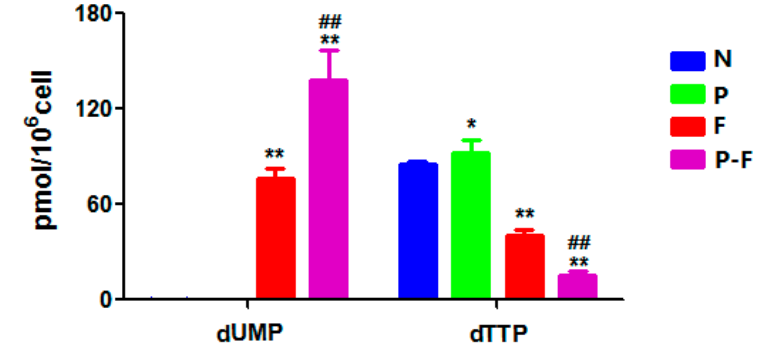
Figure 4. Levels of dUMP and dTTP after PHA and 5-FU treatments. Each group of data are represented as mean ± SD of three independent experiments. * p < 0.05 and ** p < 0.01, compared with the control group; ## p < 0.01, compared with the 5-FU group.